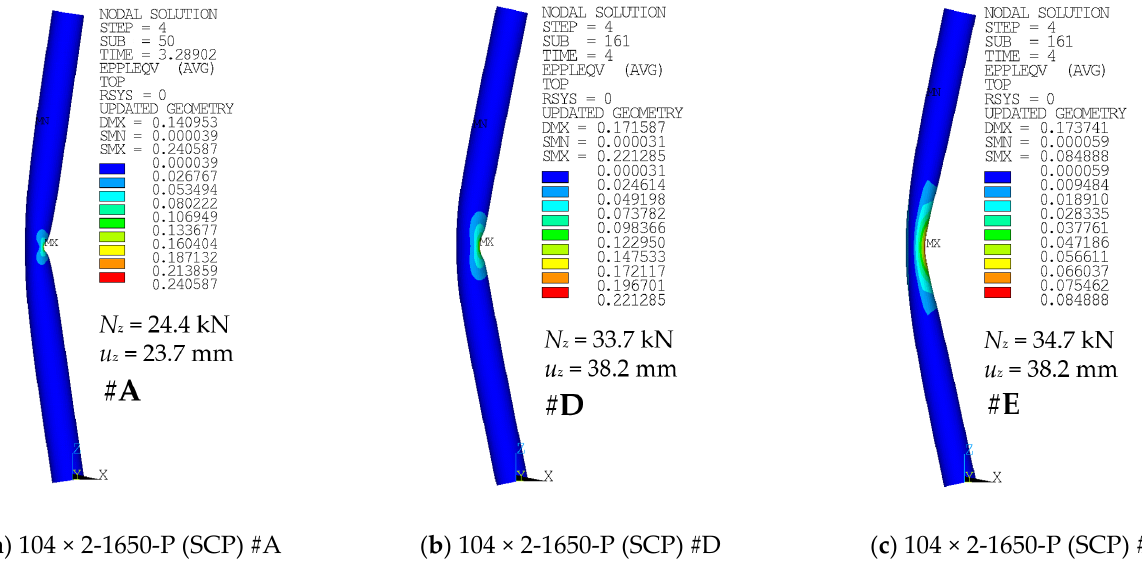
Figure 14. Equivalent plastic strains of various cases: ( a ) #A (SCP) curve from Figure 11; ( b ) #D (SCP) curve from Figure 11; and ( c ) #E (SCP) curve from Figure 11.